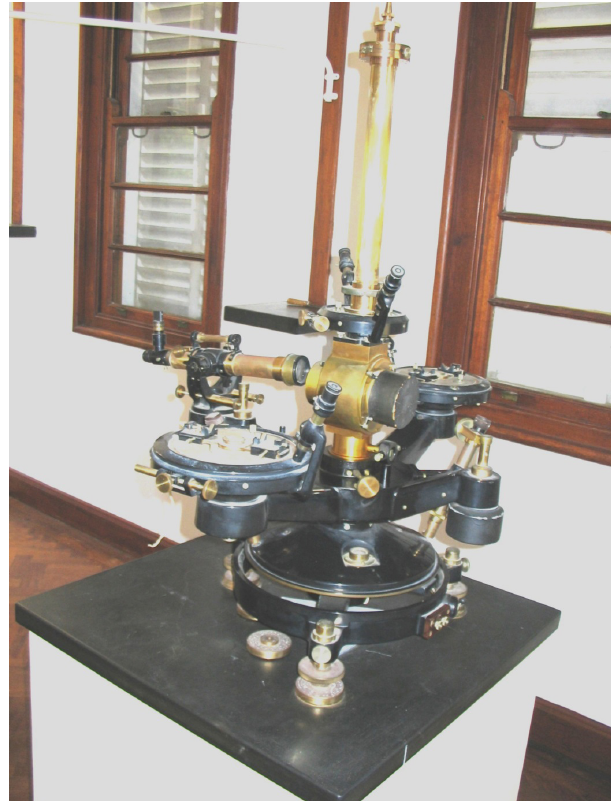
Figure 5. A Schmidt declinometer for determining the absolute value of